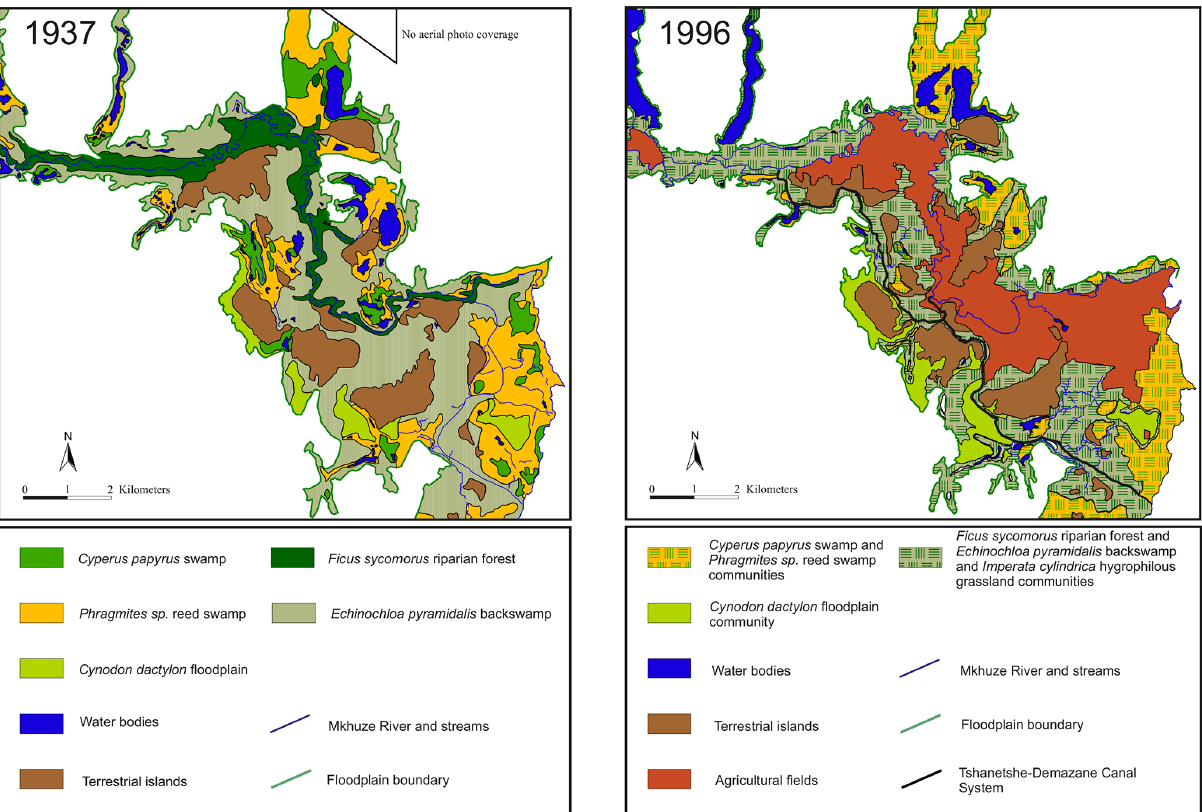
Figure 3. Distribution in the vegetation communities and land use on the Mkhuze Floodplain in 1937 (left) and 1996 (right) (adopted from Neal,